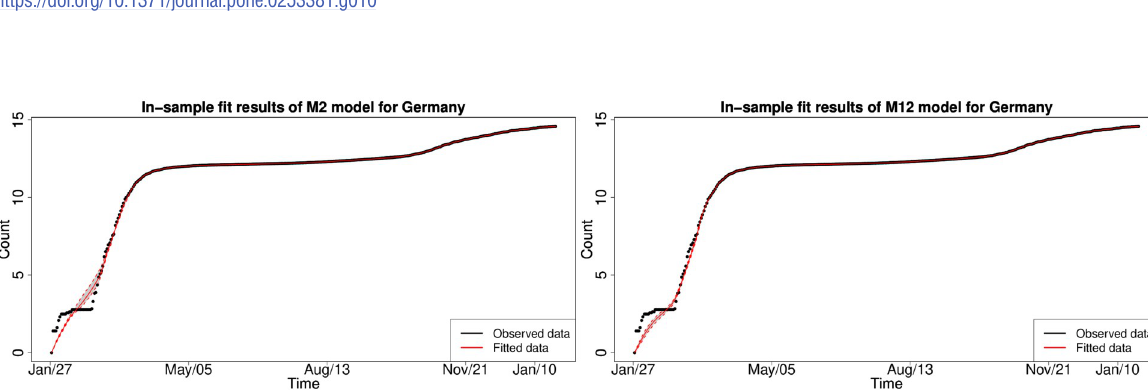
Fig 10. In-sample fit results for the UK for the period January 2020—January 2021. In-sample fitted plot (y-axis in log scale) for the UK by Model 2 (baseline, left) and Model 12 (best, right) (January 2020—January 2021).